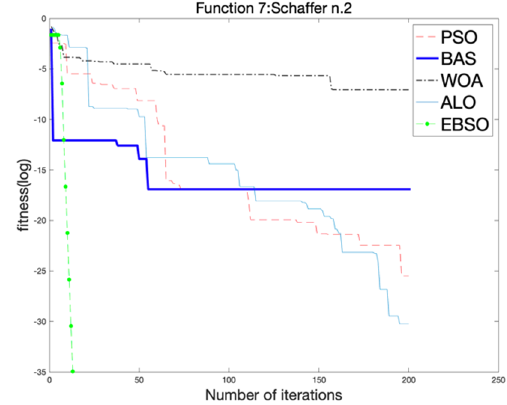
Figure 12. Iterative convergence graph.